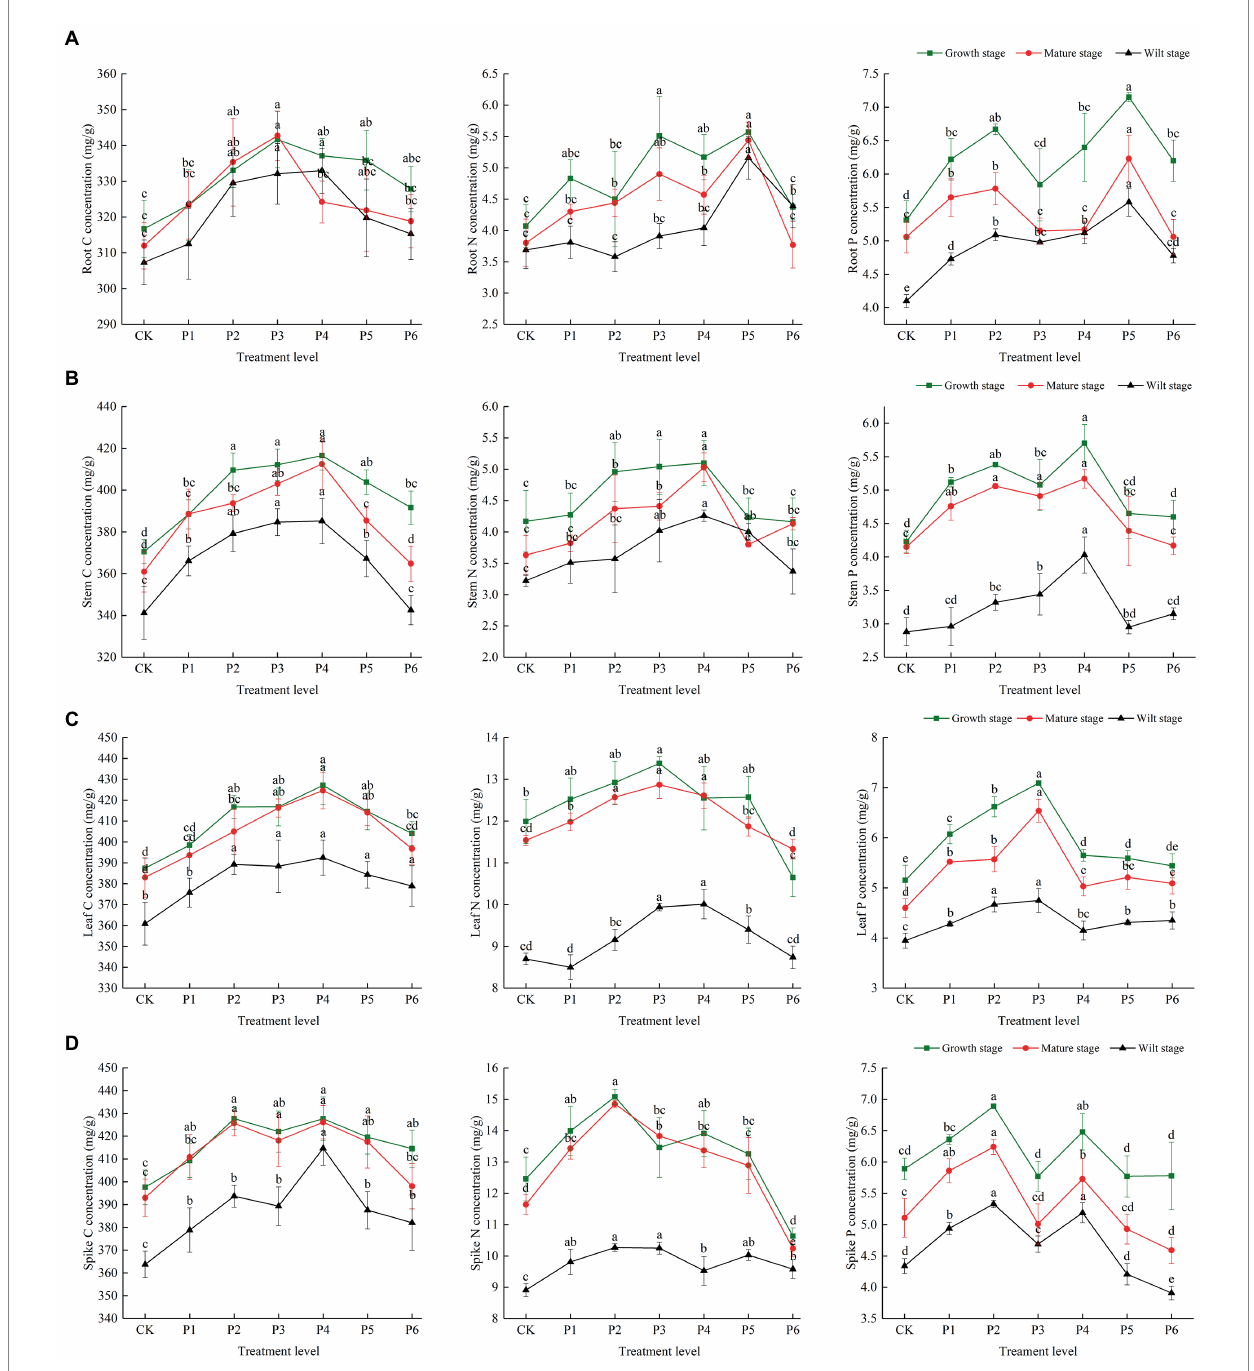
FIGURE 1 The effect of P fertilizer gradient addition on C, N, and P concentrations in different organs ( A , root; B , stem; C , leaf; D , spike) at different growth stages of bluegrass. Different lowercase letters indicate significant differences among different phosphorus additions at p <